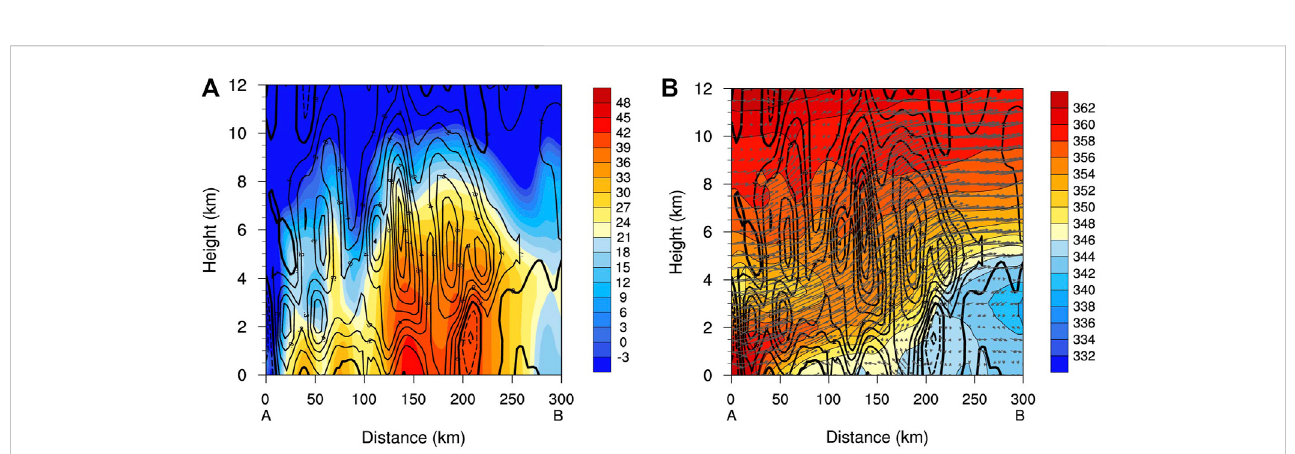
FIGURE 11 The average of fi ve vertical cross-sections along AB in Figures 10A, C of the vertical velocity (contours with interval of .1, positive values are in solid contours, negative values are in dashed contours, zero values are in bold contours; unit: m/s) with (A) re fl ectivity (shaded; unit: dBZ); (B) equivalent potential temperature(shaded;unit:K)andwinds(vectors)fromtheD02simulation.X-axiscoordinateisthehorizontaldistancefromA(unit:km),andy-axiscoordinate is the height (unit: